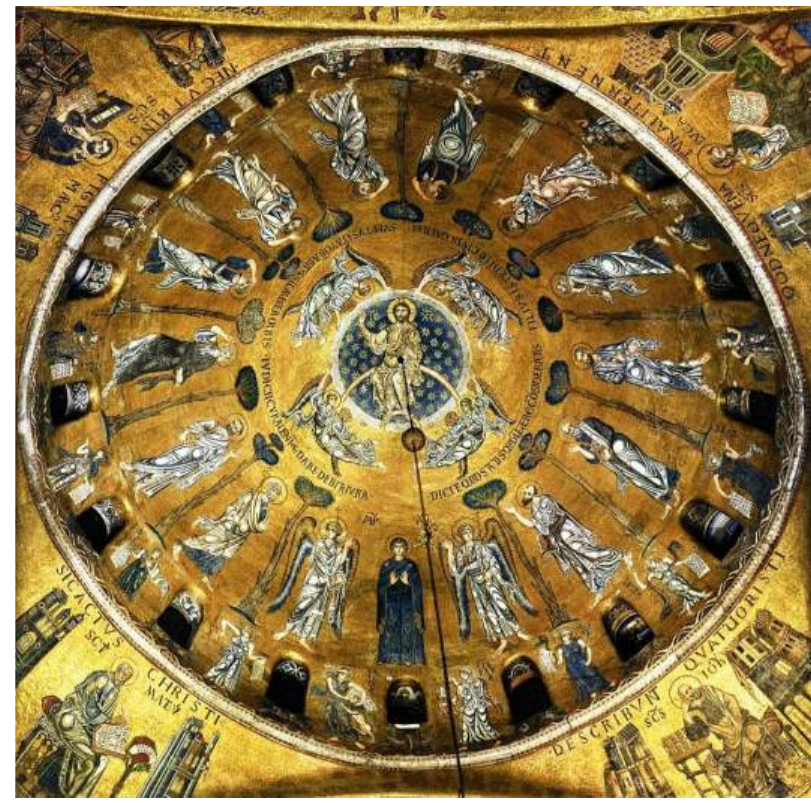
Figure 1. The spandrels of San Marco (Venice). Source: Pikaia.eu.